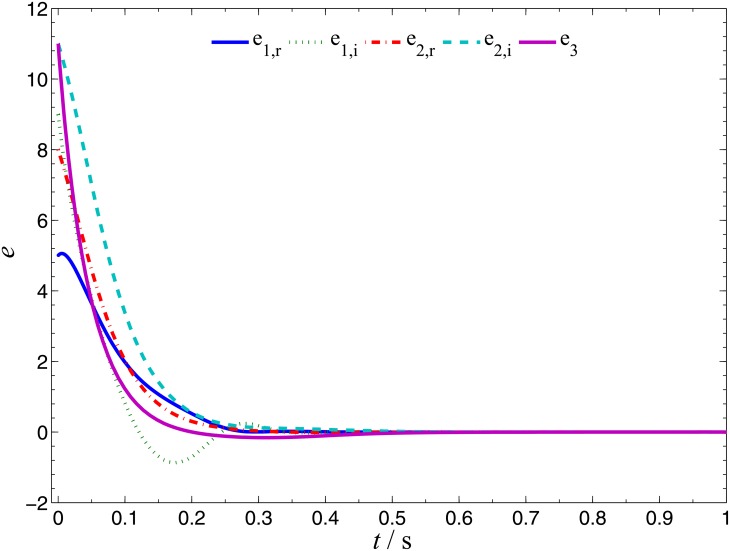
CGS errors of systems (12) and (25).